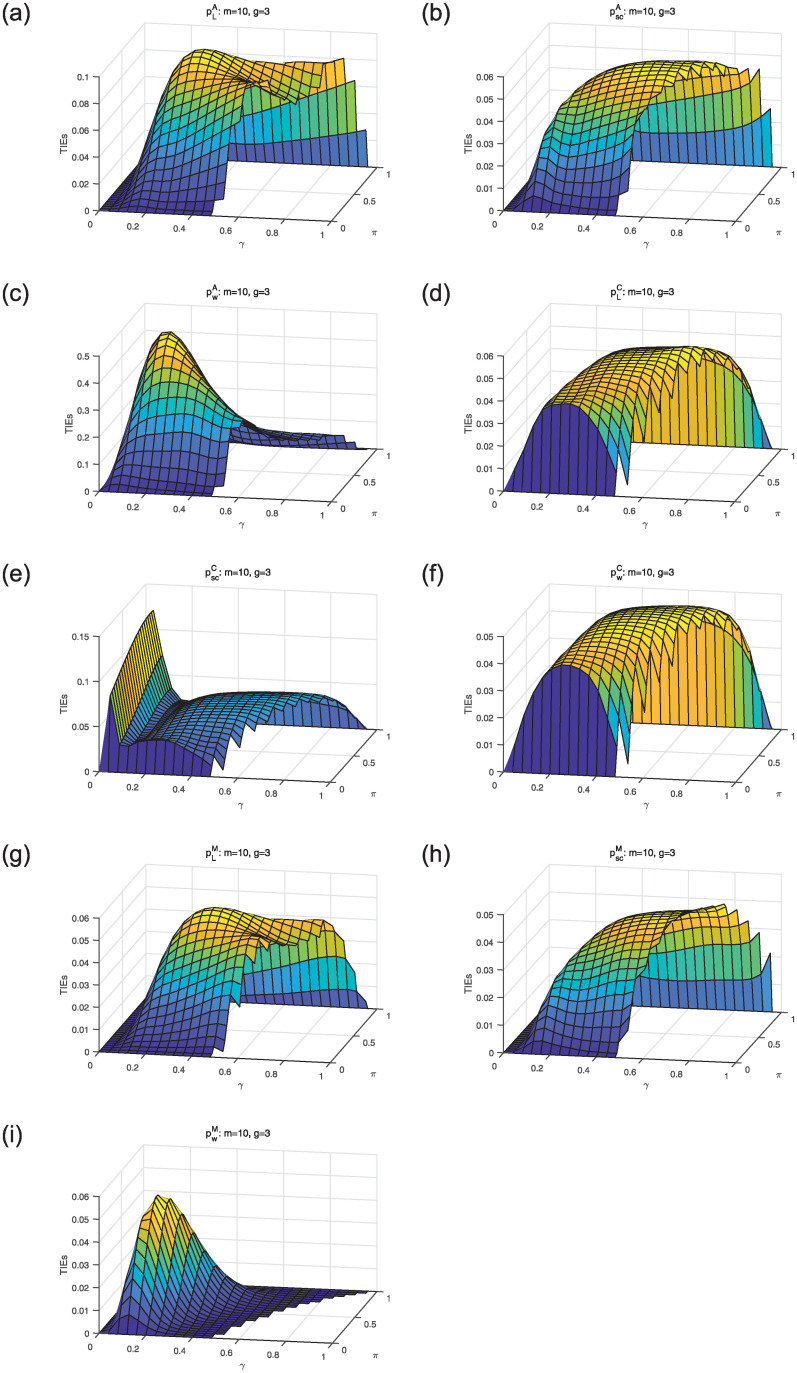
TIE surfaces of exact approaches for m = 10, g = 3, πi = π and γi = γ.